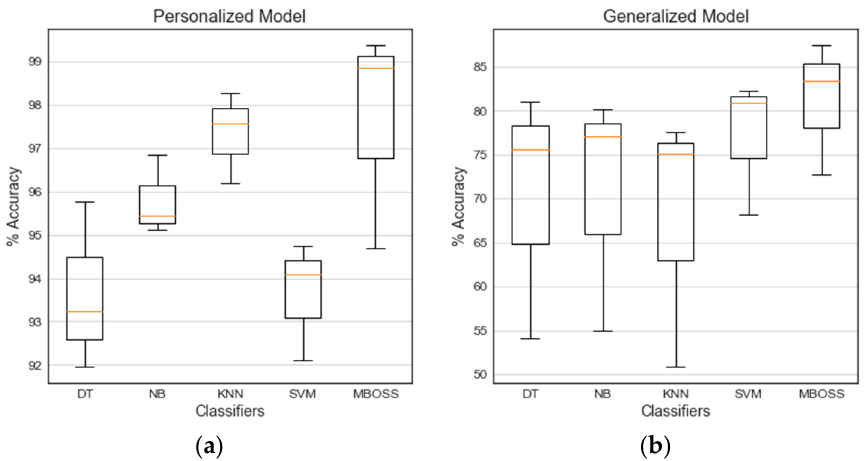
Figure 10. Classification results of ( a ) the personalized model and ( b ) the generalized model.